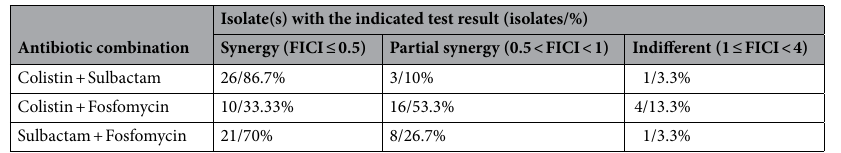
Isolate(s) with the indicated test result Antibiotic combination